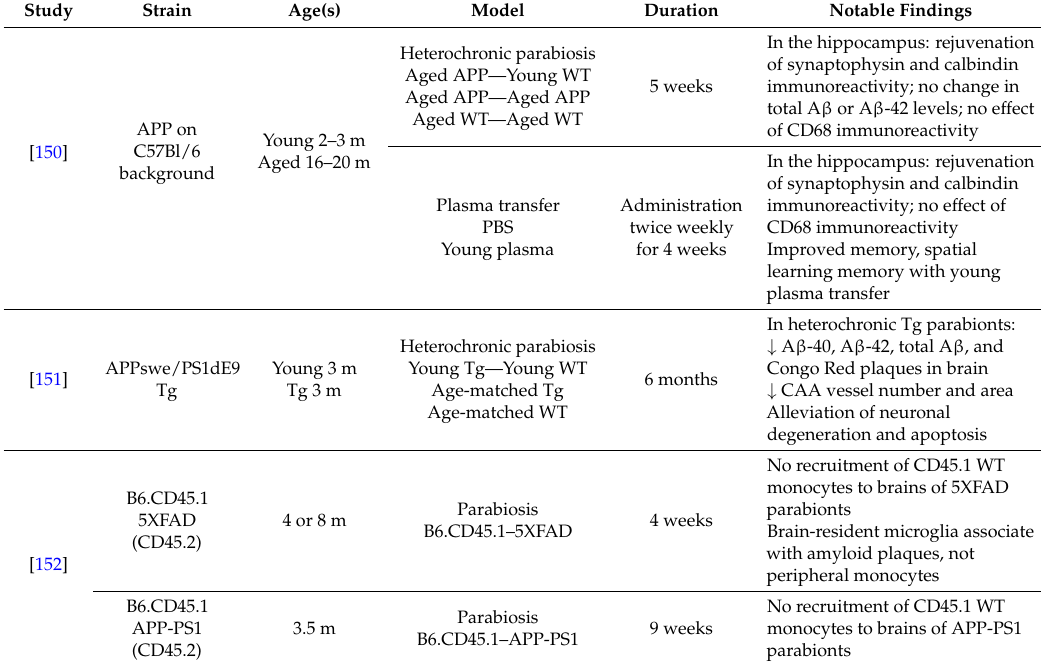
Table 2. Summary of studies examining the role of the peripheral immune system on Alzheimer’s disease (AD) pathology. Recent experiments utilizing models of parabiosis and plasma transfers are beginning to address the role of and the extent to which the peripheral immune system and soluble plasma factors may be manipulated in modifying AD pathology and cognition. ( ↑ =